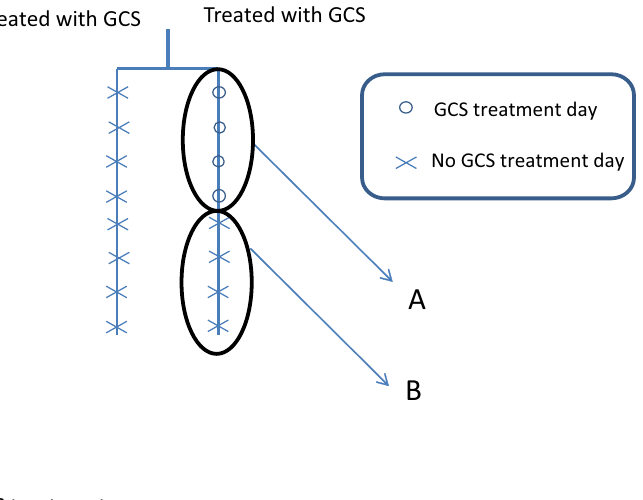
Figure 5. Linked to Table 4 (3rd model). The third model included only patients treated with GCS during their ICU stay and compared "steroid-free days" to days with GCS treatment.